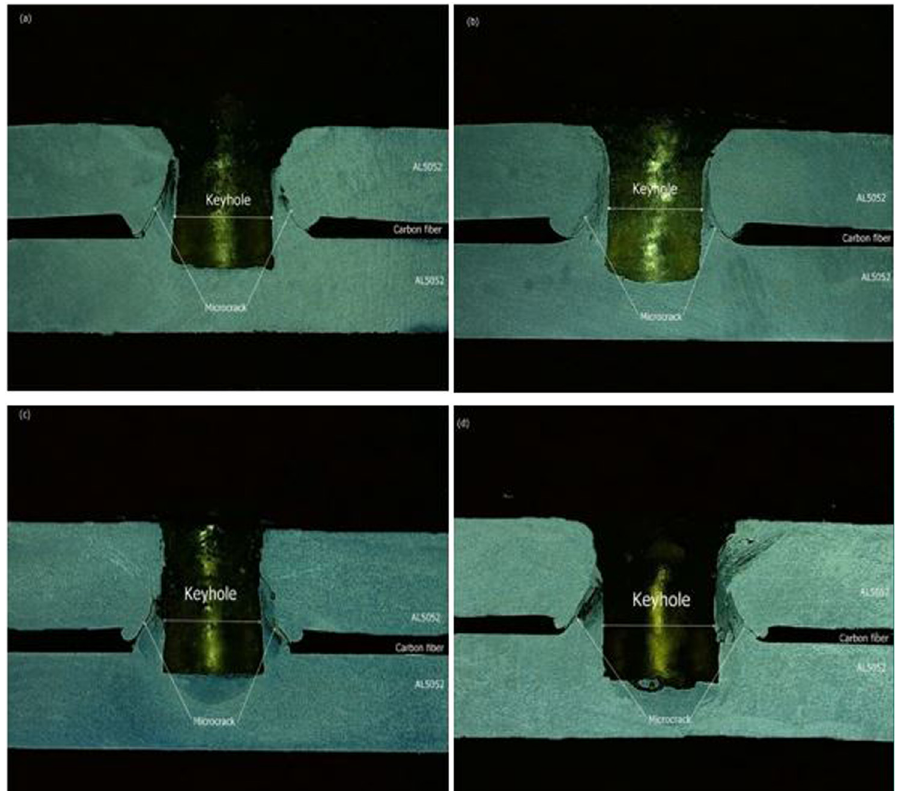
Figure 6: Cross section of the welding of samples ( a ) 850 rpm and 2 s. ( b ) 850 rpm and 5 s. ( c ) 1,300 rpm and 5 s. ( d ) 2,000 rpm and 2